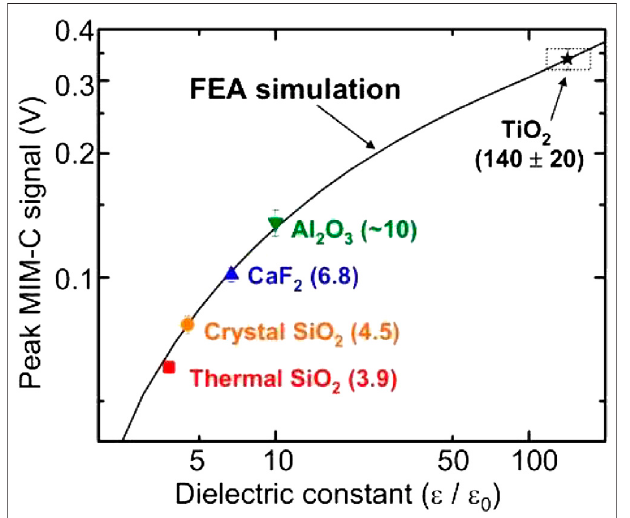
FIGURE 7 | Peak MIM-C signal in tip-sample approaching as a function ofthe relative dielectric constant[61].Reproduced withpermissionfrom Appl. Phys. Lett. 93, 12 (2008). Copyright 2008 American Institute of Physics.